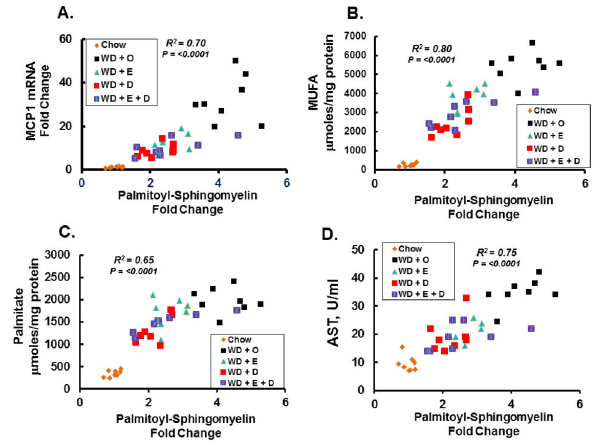
Figure 5. Diet effects on hepatic markers of inflammation, SFA, MUFA and damage. Linear regression analysis of hepatic palmitoyl-sphingomyelin (Fold Change relative to chow) versus hepatic MCP1 mRNA expression (fold change relative to chow) (Panel A); hepatic total MUFA content (µmoles total MUFA/mg protein) (Panel B); hepatic palmitate (16:0) (µmoles /mg protein) (Panel C); and plasma AST (units (U)/ml of plasma) (Panel D). Palmitoyl-sphingomyelin was quantified in the metabolomic analysis while hepatic MCP1, MUFA, palmitate, and plasma AST were quantified and reported previously [8]. Each data point in Panels A-D represents the relative abundance of palmitoyl-sphingomyelin and hepatic MCP1 mRNA, MUFA, 16:0 or plasma AST for each animal. The groups are colored-coded to facilitate visualization of the distribution in each